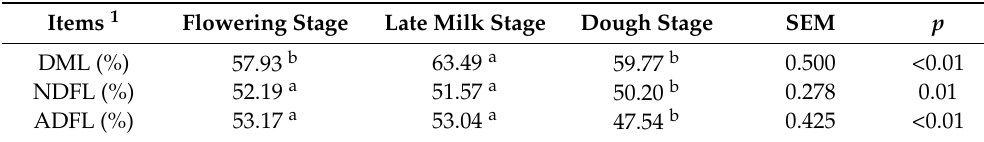
Table 4. In vitro nutrients digestibility characteristics of whole wheat hay harvested during